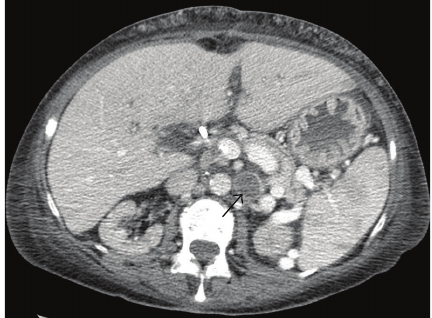
Figure 3: Postoperative CT imaging (day 47) showing the throm- bosis of the left renal vein at the point of ligation (arrow).